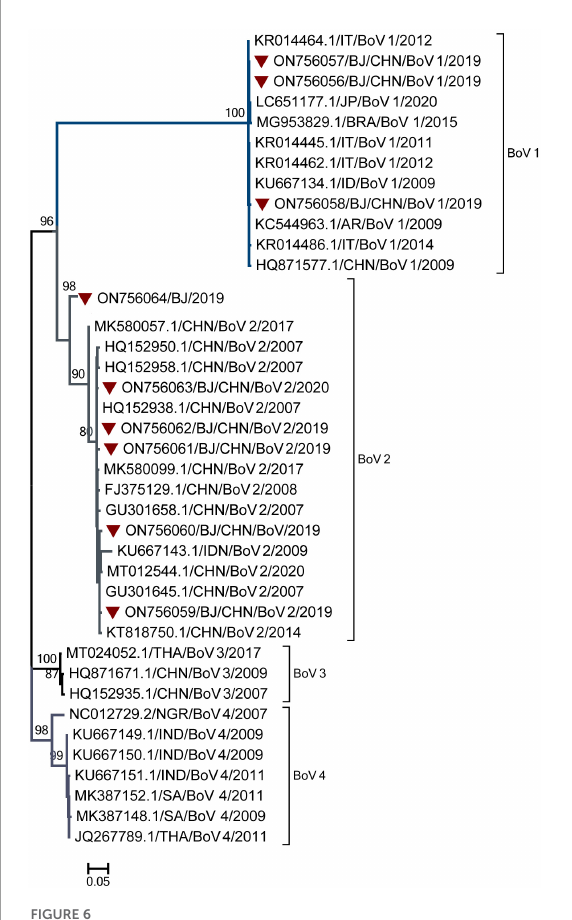
FIGURE6 The phylogenetic tree of Bocavirus (BoV) strains based on VP1 to VP2 gene region. The phylogenetic relationships were estimated by the maximum-likelihood method with GTR + G model. Human rhinovirus (HRV) strains detected in this study were marked with the symbol: (cid:72) . Bootstrap values, estimated from 1,000 replicates, are indicated at each node. The scale bar indicates the number of nucleotide substitutions per